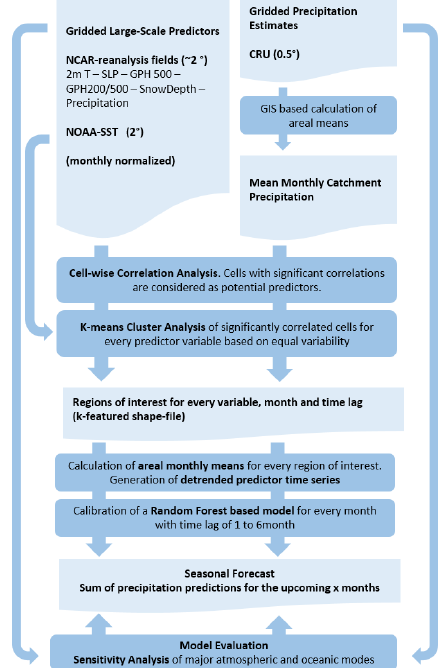
Figure 1. Flow chart representing the major components of the sea- sonal forecast